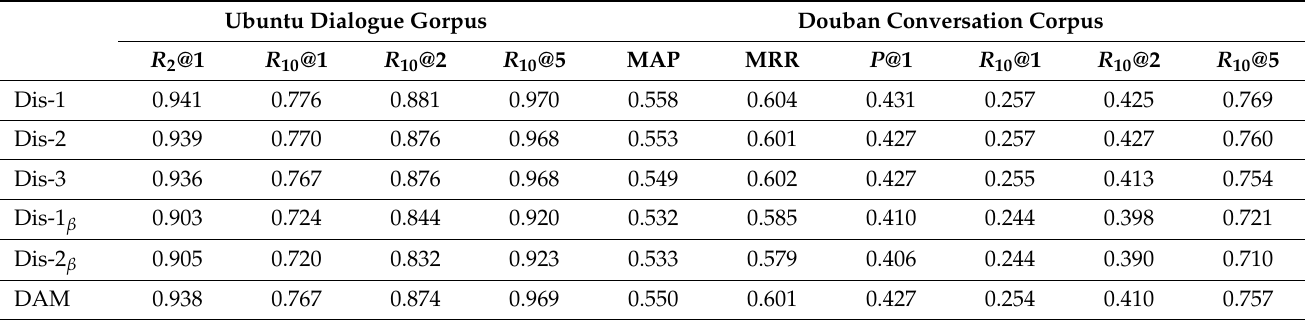
Table 5. Compare the results of different shift distances under the shifted granularity matching method.